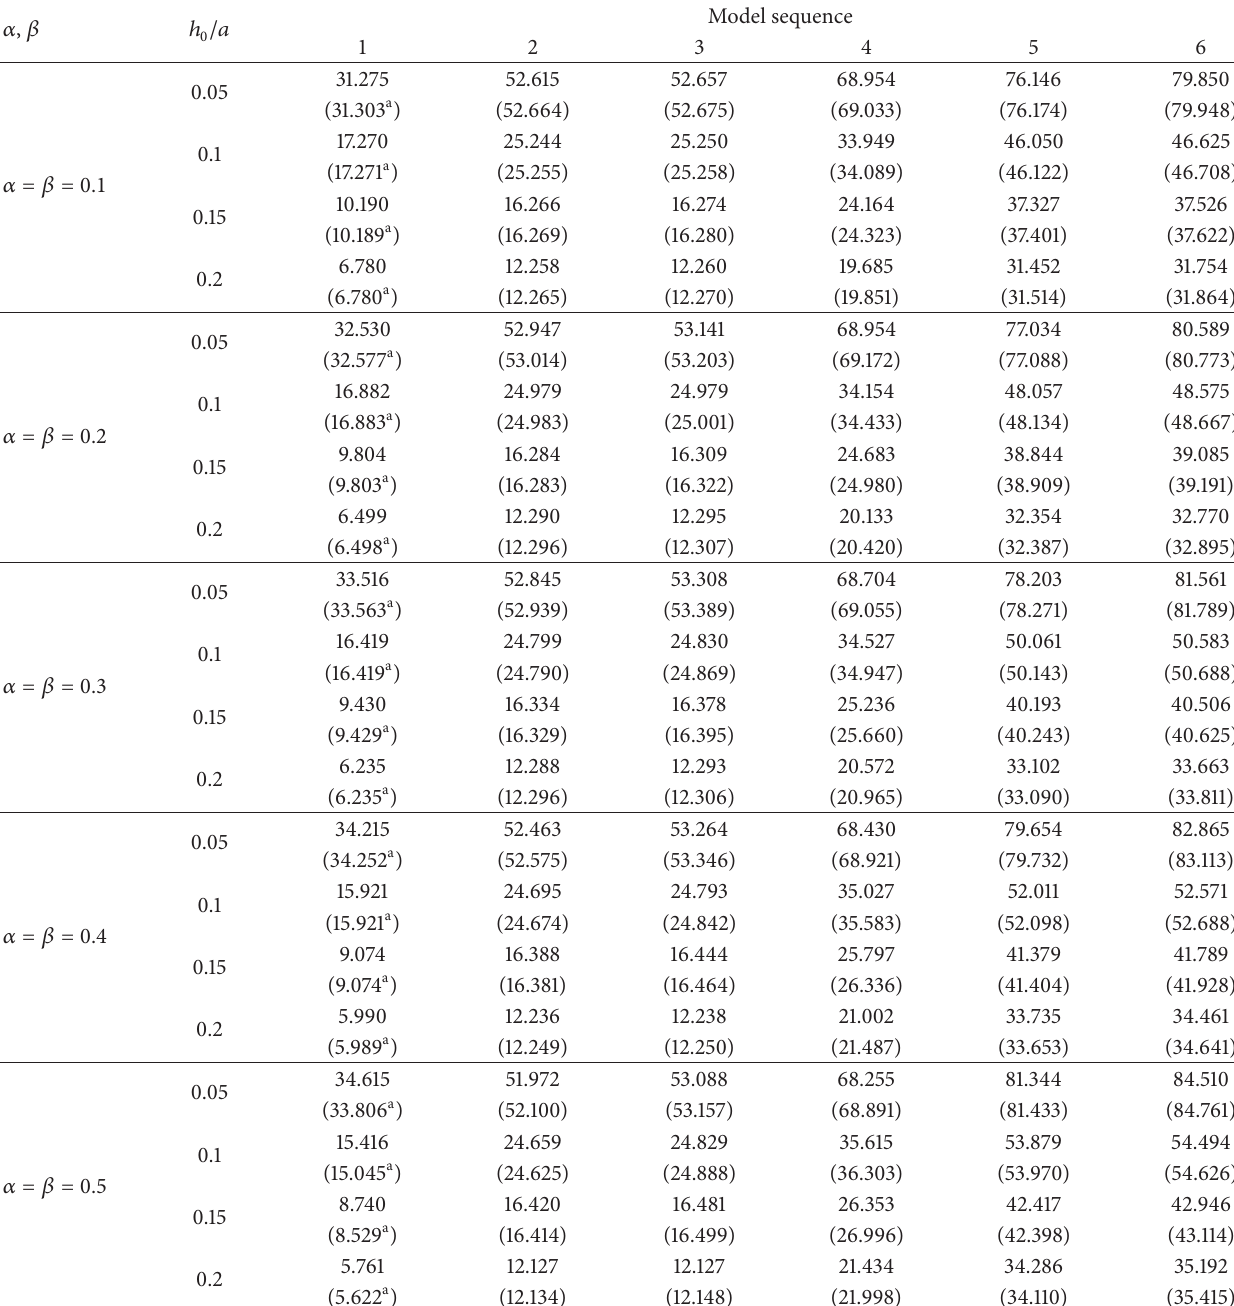
Table 8: Frequency parameter Ω = 𝜔𝑎 2 (𝜌ℎ 0 /𝐷 0 ) 1/2 for elastic support moderately thick plates ( 𝑎/𝑏 = 1 ) with different gradient ( 𝑘 𝑥0 = 𝑘 𝑥𝑎 =